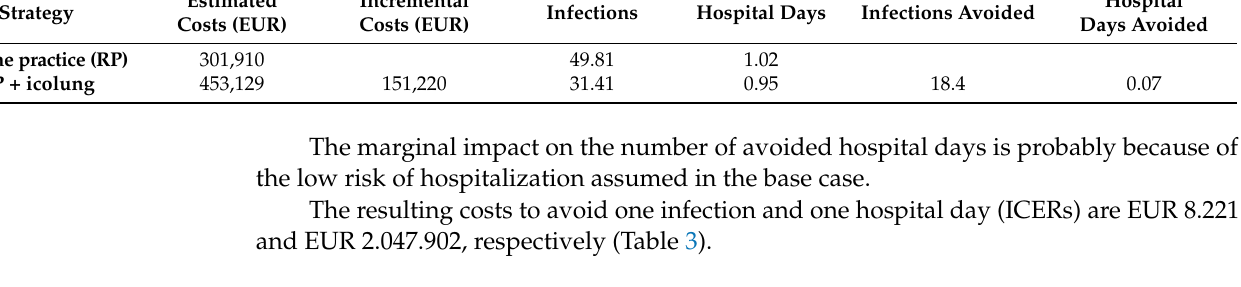
Table 3. Base case analysis results, incremental cost-effectiveness ratio (ICER): costs to avoid one infection and one hospital